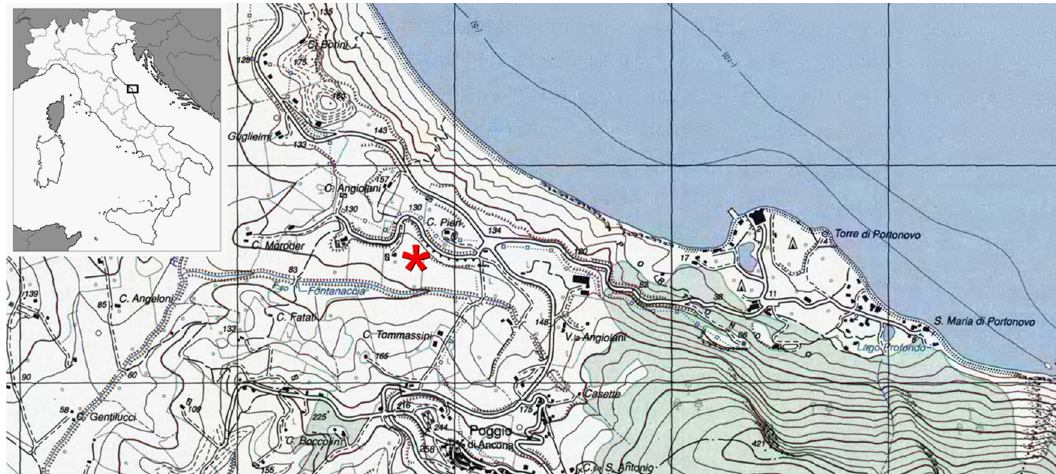
Figure 1: Localisation of the archaeological site of Portonovo ( Marche, Italy ) . IGM Map 1:25.000, 118 –